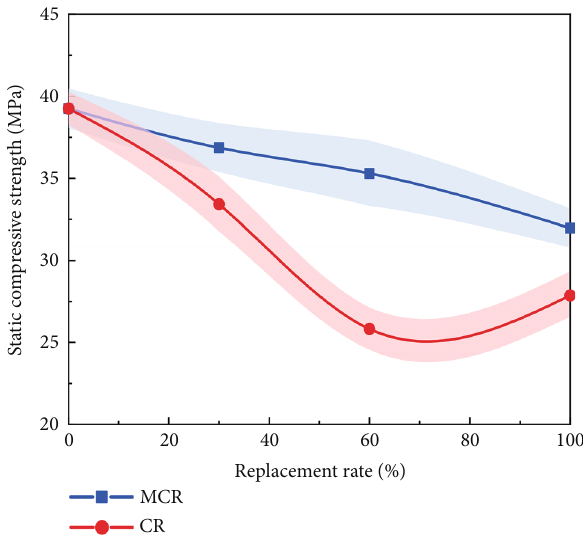
Figure 3: Quasi-static compressive strength of